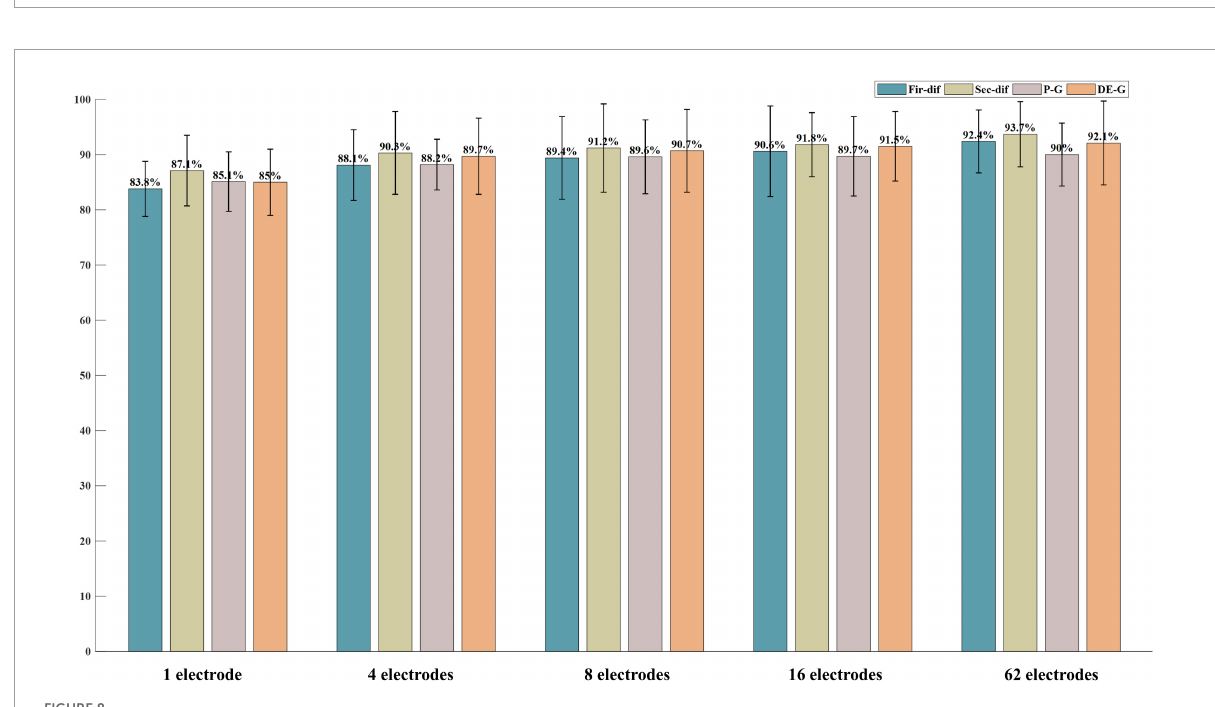
FIGURE8 The classification results of features from 1, 4, 8, 16, and all 62 electrodes on the ESD